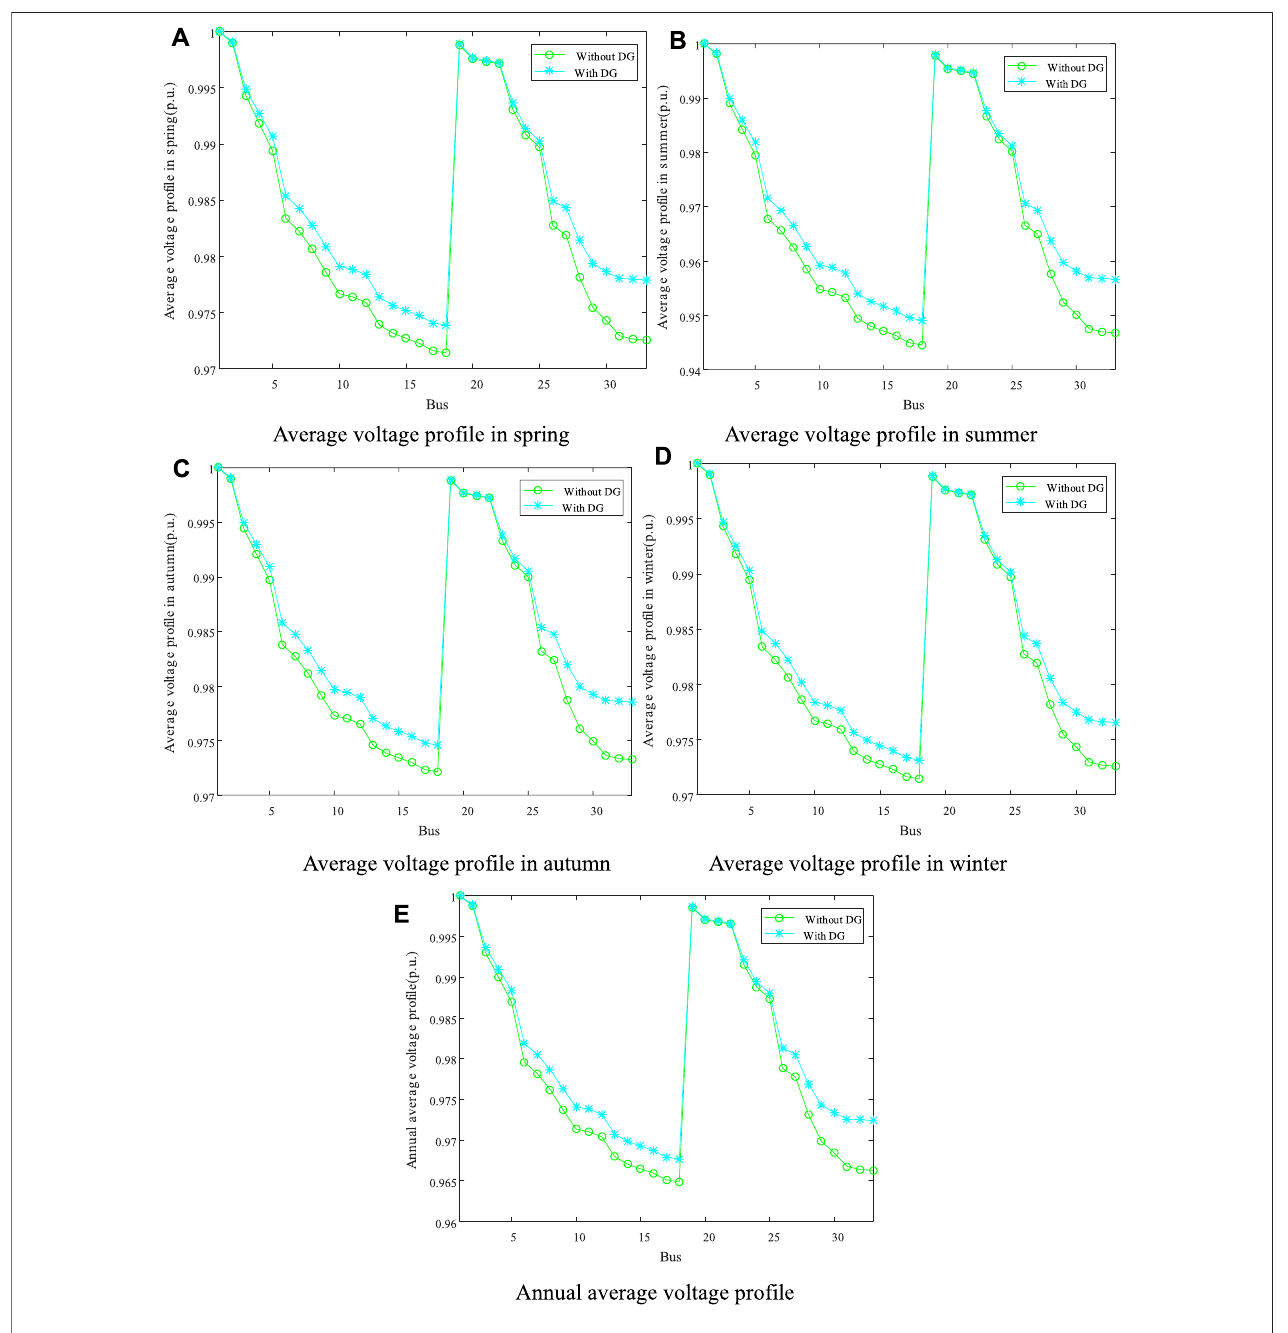
FIGURE 6 | Voltage pro fi le improvement of the IEEE 33-bus distribution network. (A) Average voltage pro fi le in spring. (B) Average voltage pro fi le in summer. (C) Average voltage pro fi le in autumn. (D) Average voltage pro fi le in winter. (E) Annual average voltage pro fi le.